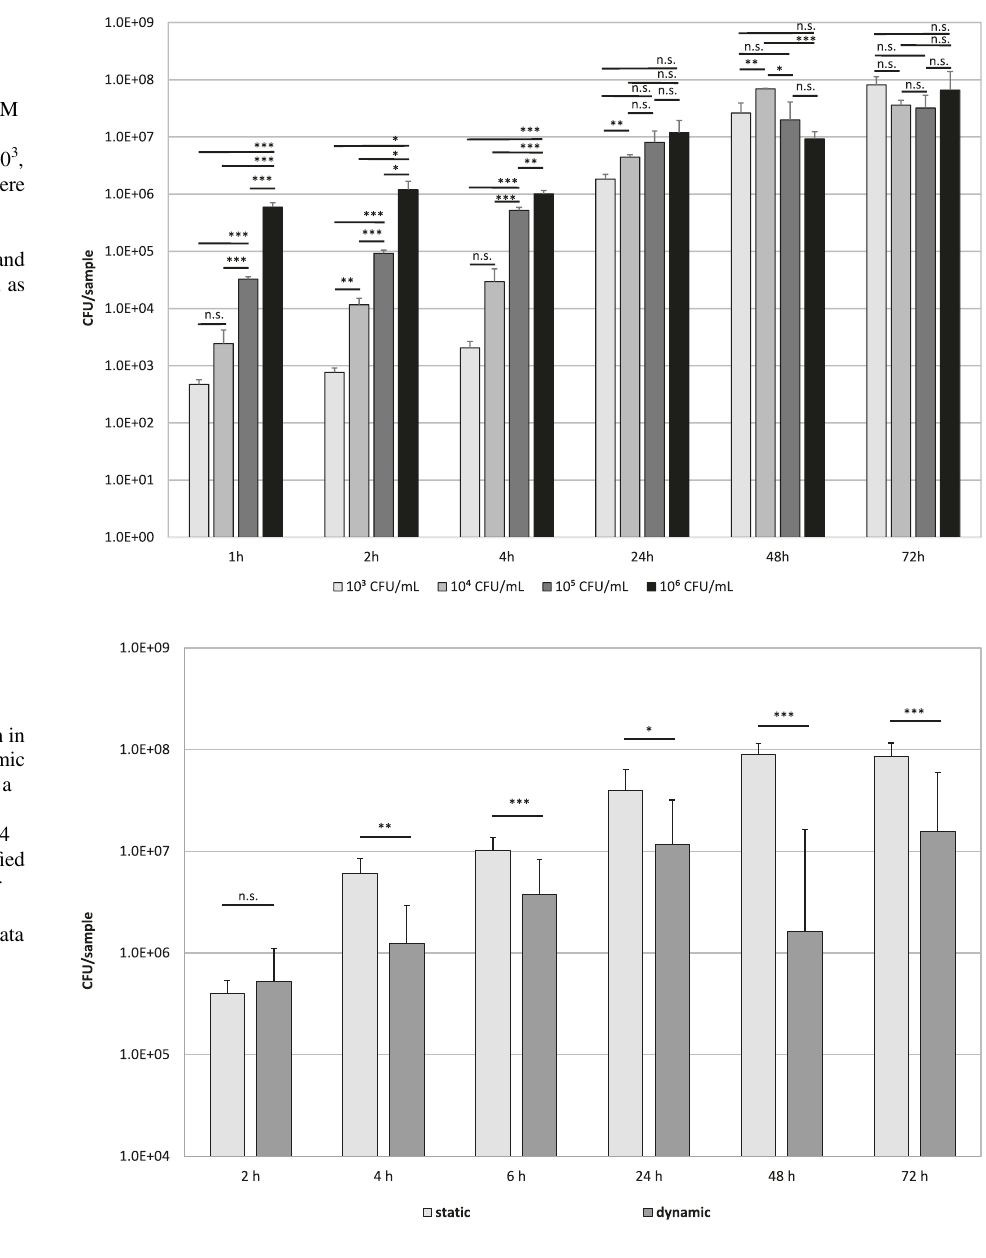
Fig. 5 In fl uence of static and dynamic conditions on formation of P. fl uorescens bio fi lm during 72 h incubation in LBM in 96-well MTP. Dynamic conditions were created with a wobble shaker at 200 rpm. Medium was changed after 24 and 48 h. Bio fi lm was quanti fi ed by colony forming units after bio fi lm separation and serial dilution as total CFU/well. Data are given as mean ± standard